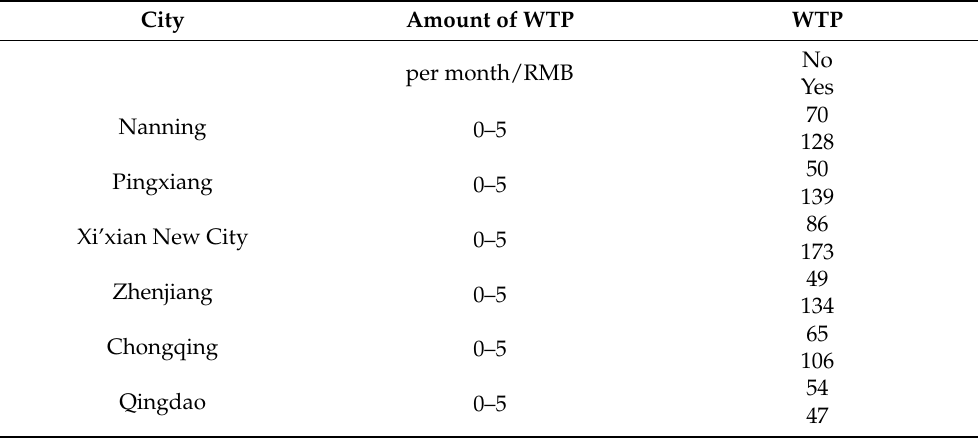
Table 2. The results of respondents’ WTP and the amount of their WTP. City Amount of